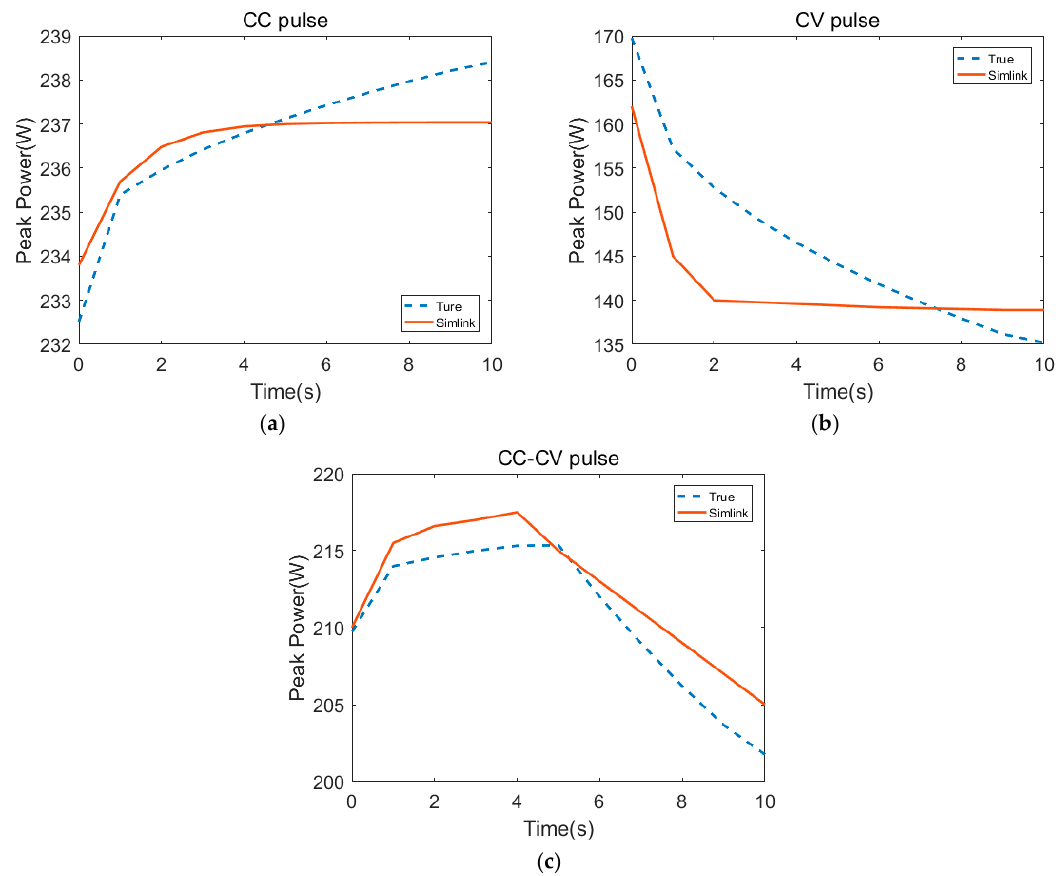
Figure 12. Pulse peak power: ( a ) CC pulse; ( b ) CV pulse; ( c ) CC-CV pulse.